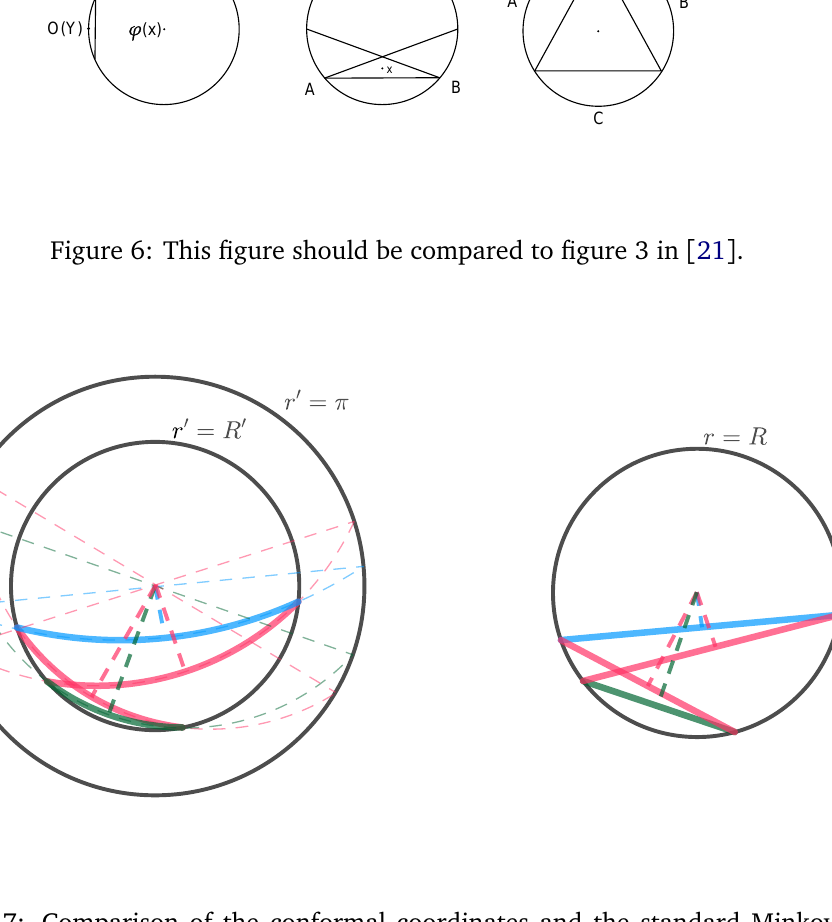
Figure 7: Comparison of the conformal coordinates and the standard Minkowski polar coordinates. The r = ∞ of polar coordinates gets mapped to r (cid:48) = π . The union / intersection structures within the cut-off are isomorphic to that in